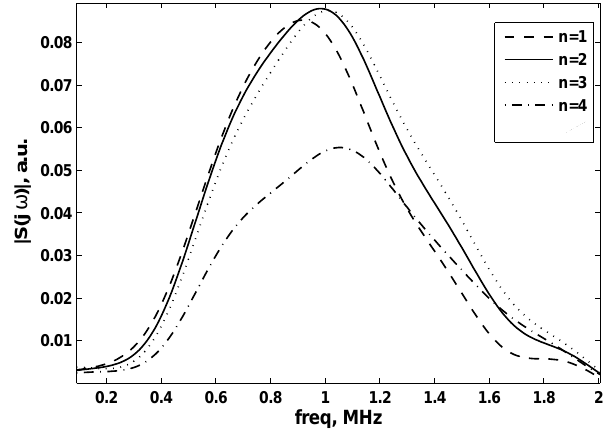
Figure 7. Fourier transform absolute values of signals situated at the center of the sound beam (Line 1) for different values of n (see also Figure